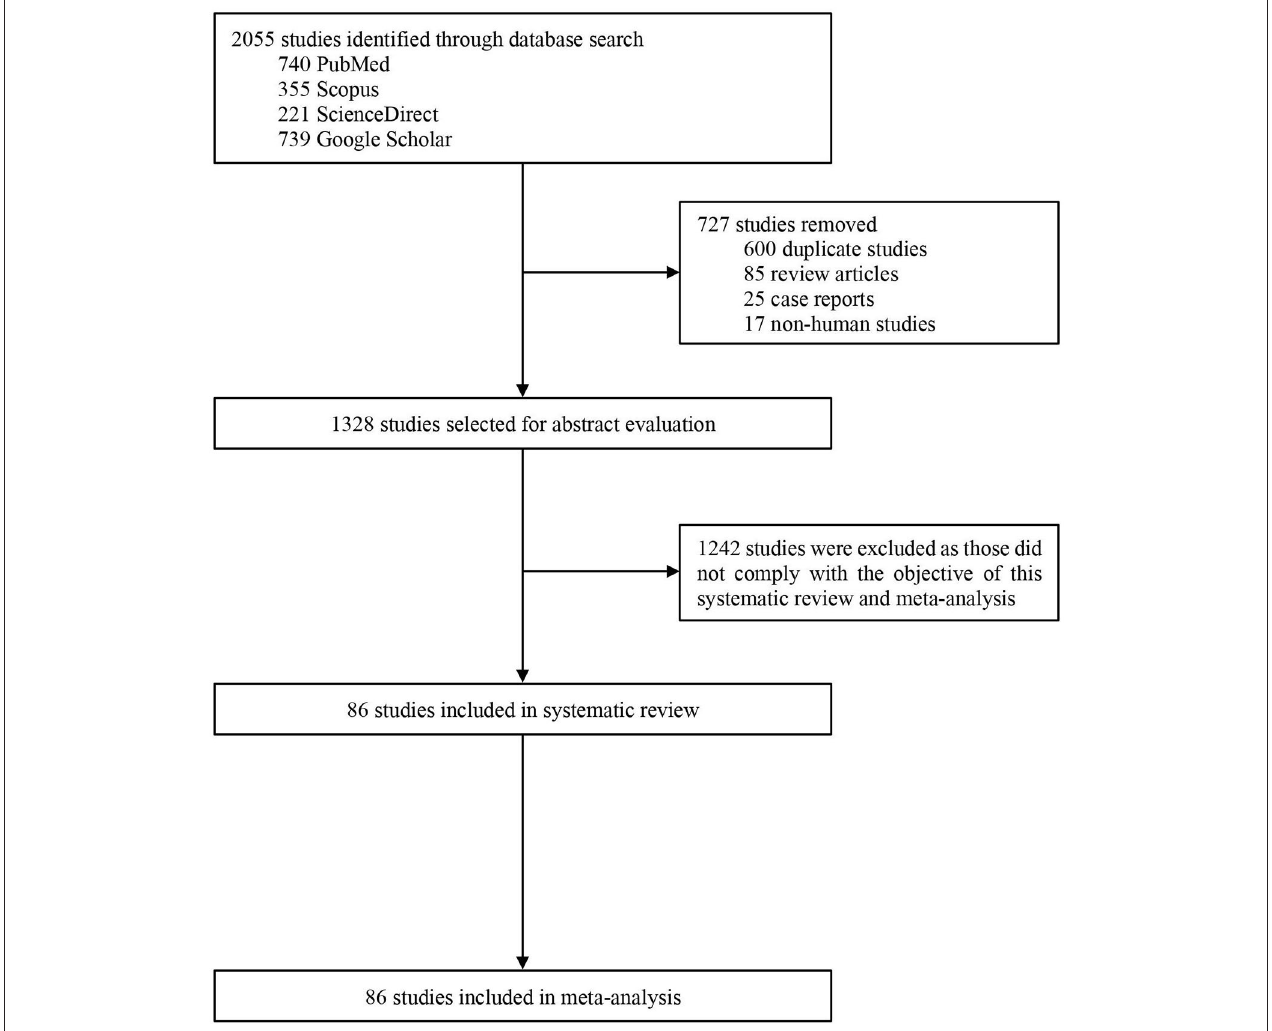
FIGURE 1 | PRISMA flow diagram of study